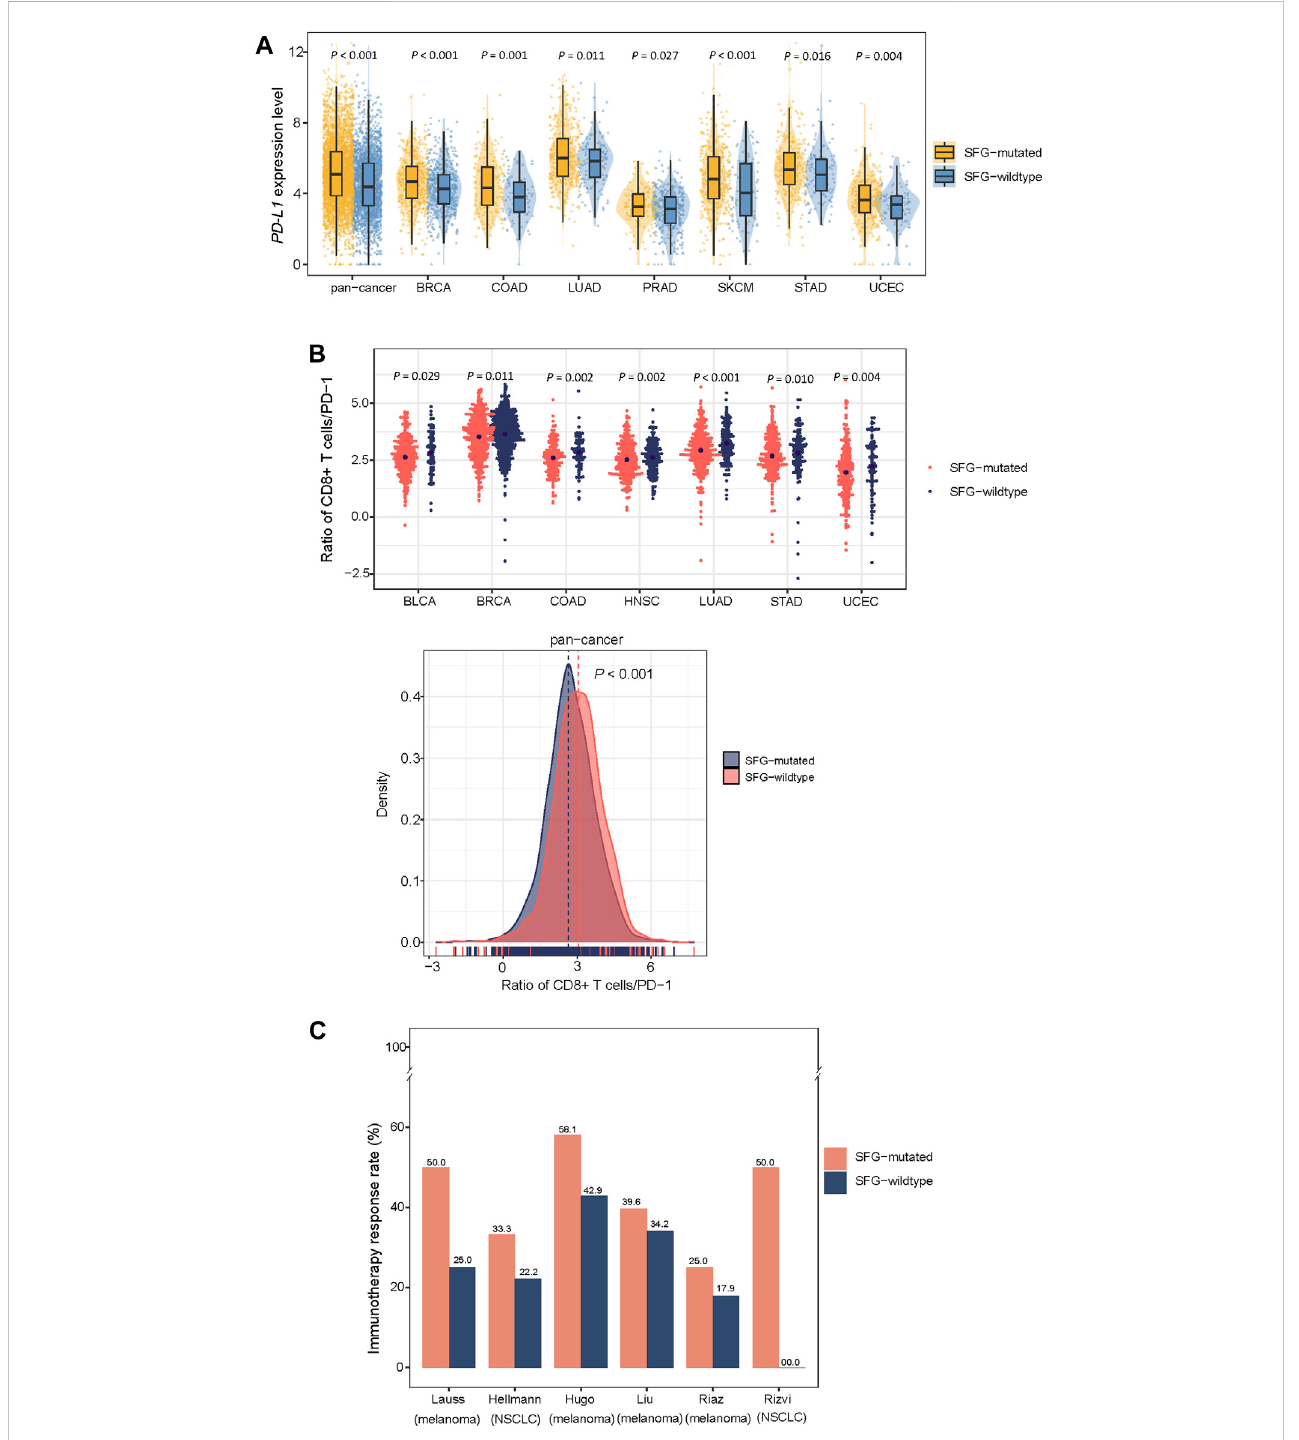
FIGURE 3 SFG mutations correlate with reduced anti-tumor immune responses and increased immunotherapy response in cancer. SFG-mutated tumors have higherexpressionlevelsof PD-L1 (A) andtheratiosofimmune-stimulatorytoimmune-inhibitorysignatures(CD8 + Tcells/PD-1) (B) thanSFG-wildtypetumors in pan-cancer and in seven cancer types. The Student ’ s t test p values are shown in (A,B) . (C) SFG-mutated tumors have higher response rates to immune checkpoint inhibitors (ICIs) than SFG-wildtype tumors in six cancer